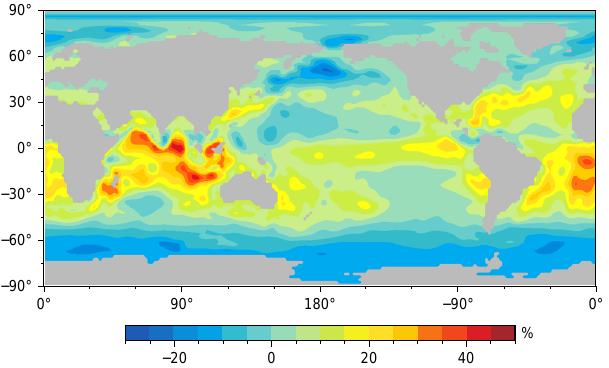
Figure 7. Annual mean depth-integrated ocean flow velocities over the upper 1040m.